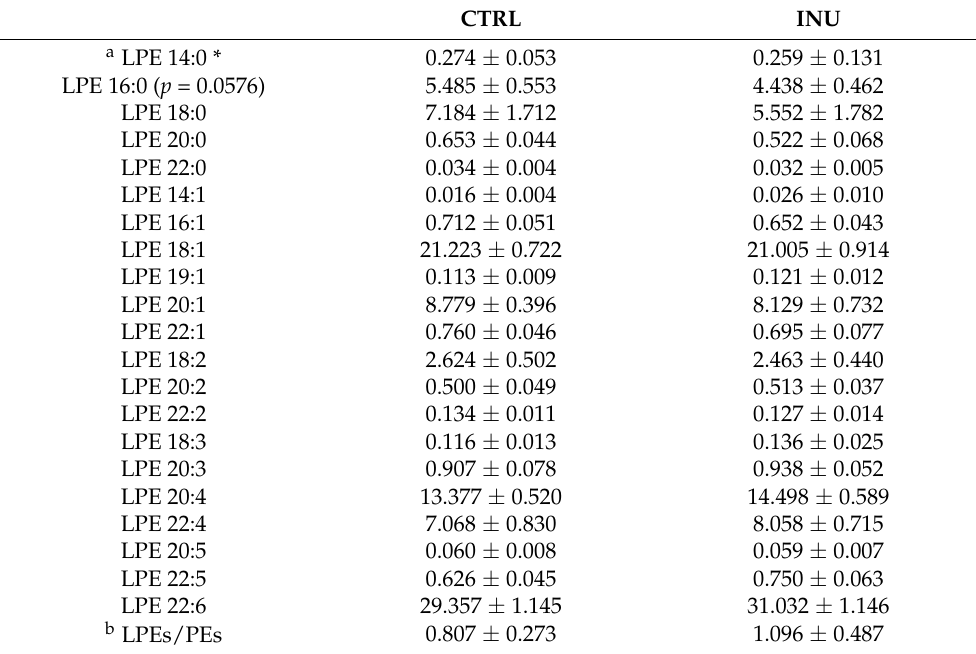
Table 4. Relative abundance of lyso-phosphatidylethanolamine species in the cortex.